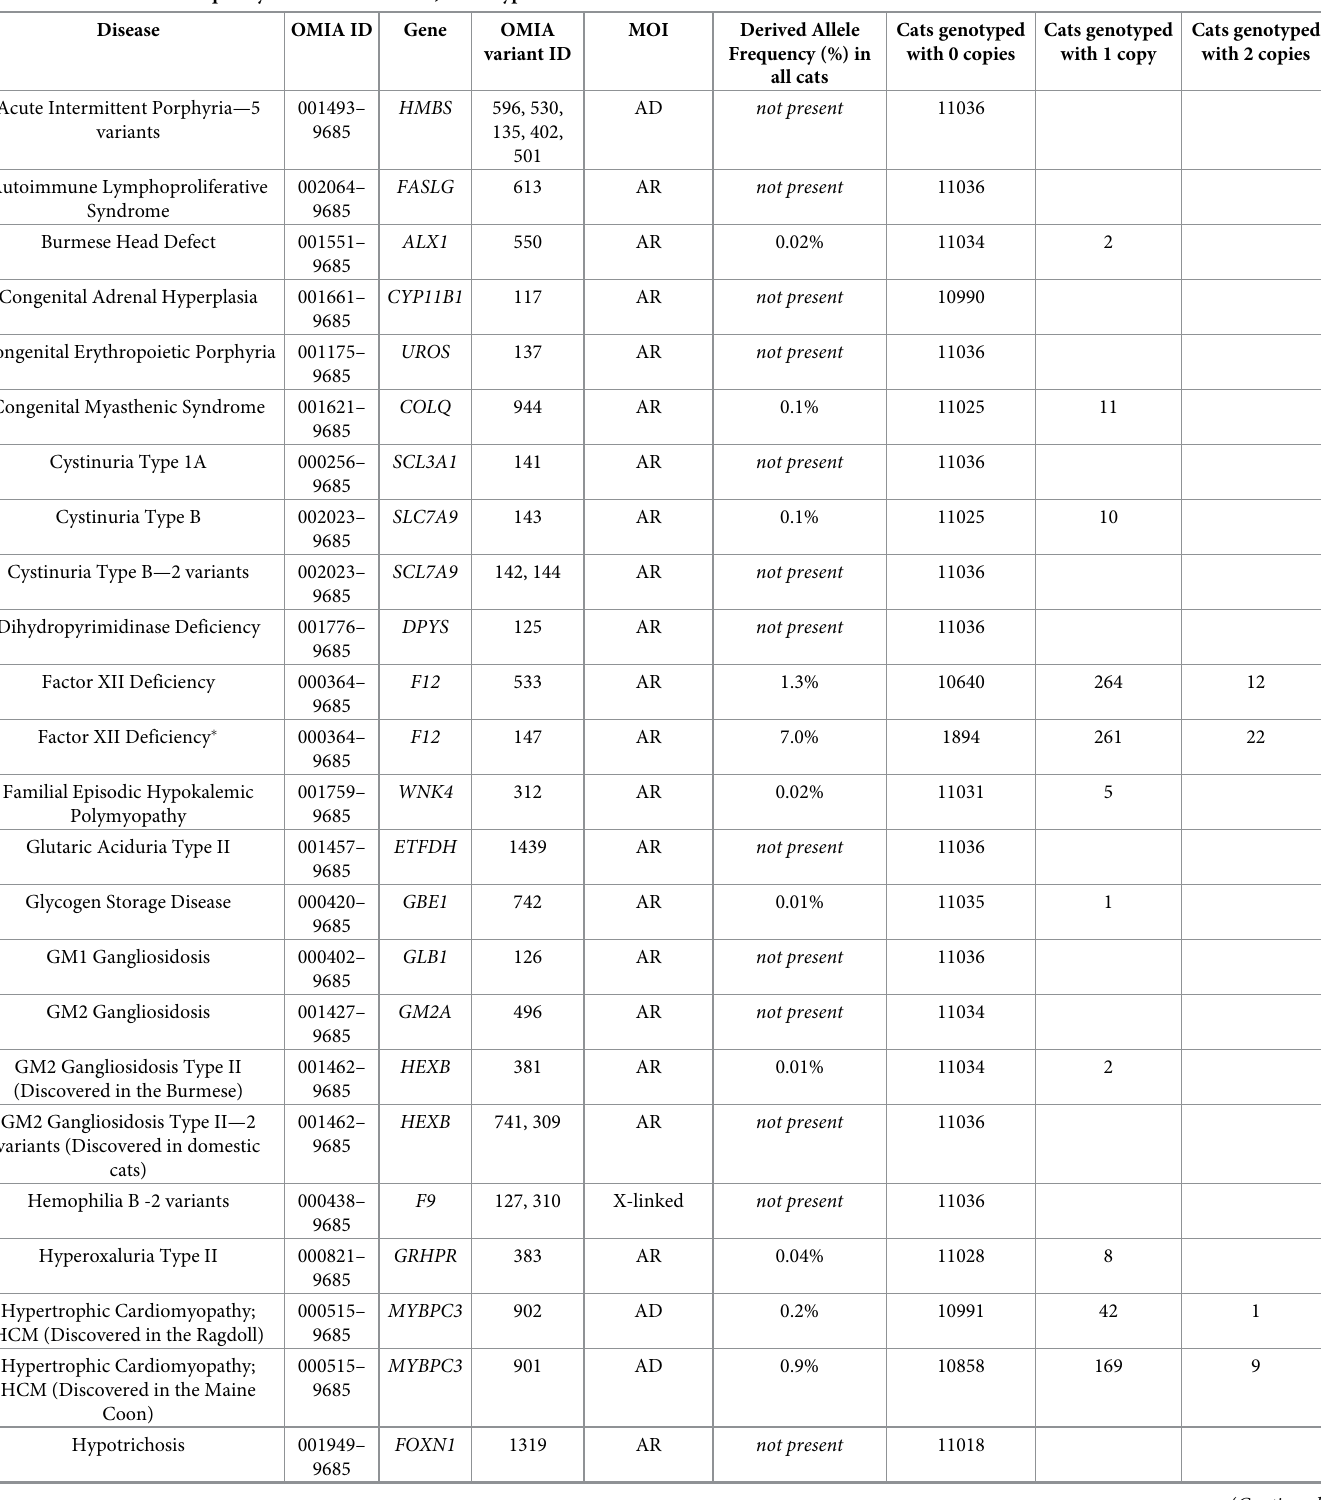
Table 1. Prevalence and frequency of the tested disease, blood type and trait -associated variants in all